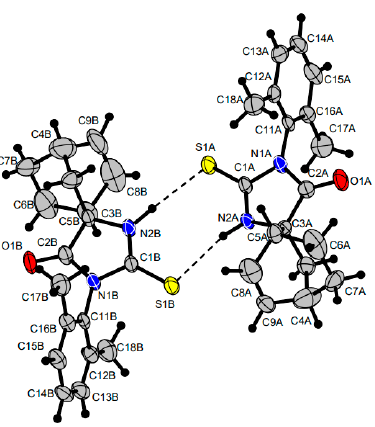
Figure 2. Molecular structure of compound 51a . Thermal ellipsoids are given a 30% probability.